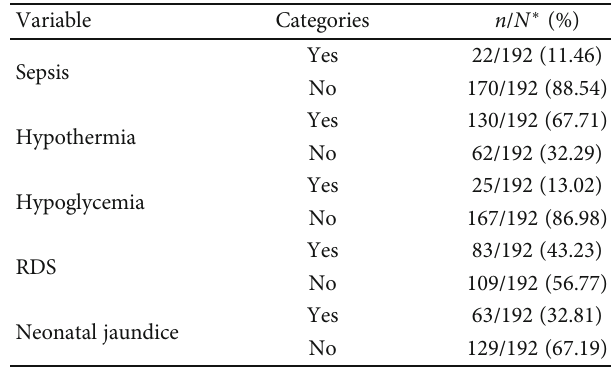
Table 2: Comorbidities of preterm babies at presentation to the